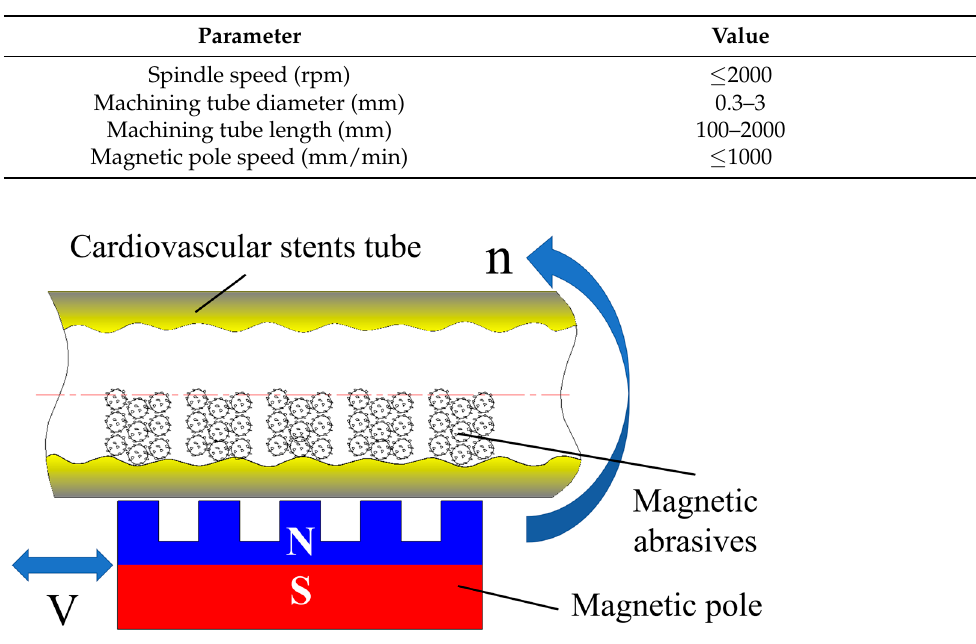
Table 2. Equipment performance parameters.